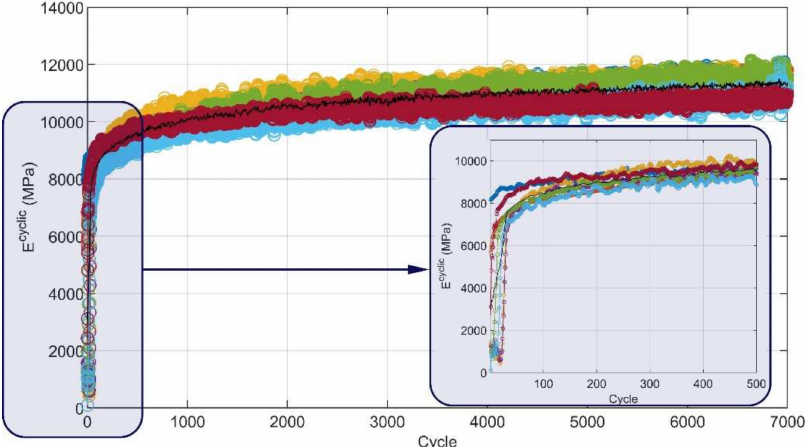
Figure A3. E cyclic of n = 8 samples during 7000 cycles. Each specimen is shown in a different colour; mean values are in black.